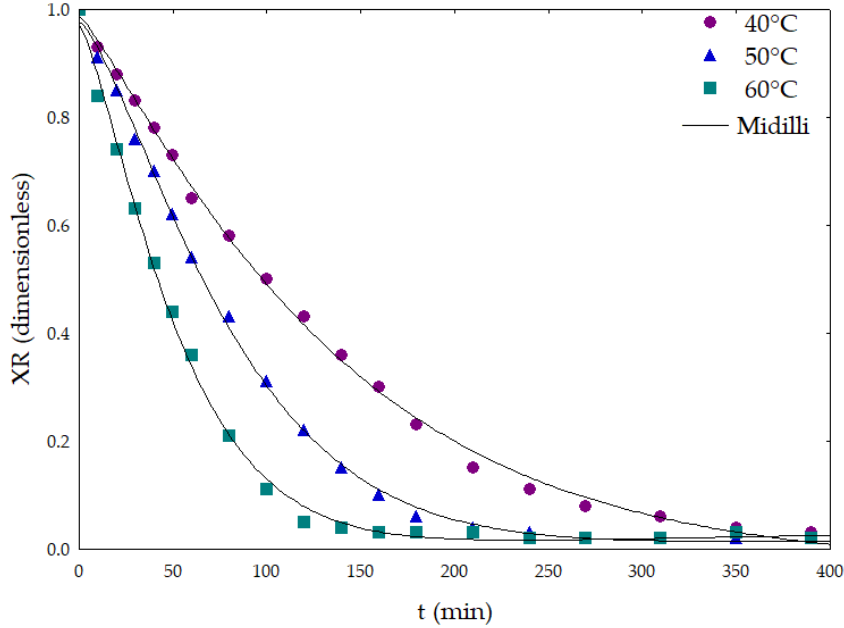
Figure 1. Values of moisture ratio versus time in thin-layer drying of Lippia thymoides leaves, adjusted using the Midilli model.